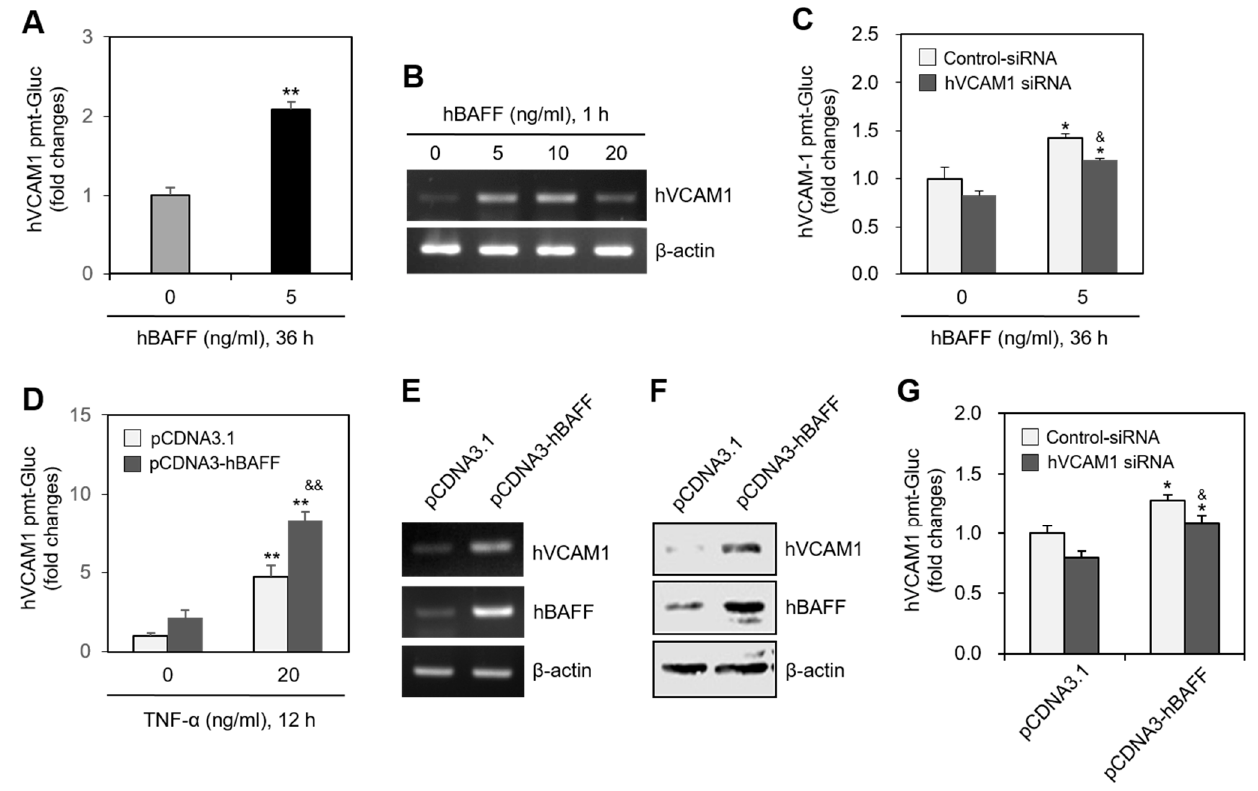
Figure 3. Human vascular cell adhesion molecule-1 (hVCAM1) expression was up-regulated by the treatment or the overexpression of hBAFF. ( A ) MH7A cells were transfected with pEZx-PG02-hVCAM1-gaussia luciferase (Gluc) plasmid DNA by using polyethylenimine (PEI), and treated with 5 ng/mL hBAFF protein. Gluc activity was measured by using luminometer. ( B ) MH7A cells were treated with various concentrations of hBAFF protein. RNA was purified with Nucleozol ® . hVCAM1 expression was detected by RT-PCR. ( C ) MH7A cells were transfected with control or hVCAM1-siRNA to knockdown hVCAM1 expression by using Lipofectamine ® . Then, cells were transfected with pEZx-PG02-hVCAM1-Gluc plasmid DNA by using PEI and treated with 5 ng/mL hBAFF protein. Gluc activity was measured by using luminometer. ( D – F ) MH7A cells were co-transfected with pCDNA3.1, or pCDNA3-hBAFF and pEZx-PG02-hVCAM1-Gluc plasmids by using PEI. Gluc activity was measured by using luminometer ( D ). RNA was purified with Nucleozol ® . hVCAM1 expression was detected by RT-PCR ( E ). Cell lysates were prepared and hVCAM1 protein level was detected by western blot analysis ( F ). ( G ) MH7A cells were transfected with control or hVCAM1-siRNA to knockdown hVCAM1 expression by using Lipofectamine ® . Then, cells were co-transfected with pCDNA3.1, or pCDNA3-hBAFF and pEZx-PG02-hVCAM1-Gluc plasmid DNA by using PEI. Gluc activity was measured by using luminometer. Each experiment was performed at least four times. Data in a bar graph represent the means ± SD. * p < 0.05, ** p < 0.01; significantly different from hBAFF protein-untreated ( A , C ) or pCDNA3.1-treated and TNF- α -untreated ( D , G ) or control group. & p < 0.05, && p < 0.01; significantly different from control-siRNA-treated and hBAFF protein-treated ( C ) or pCDNA3.1-transfected and TNF- α -treated ( D ) or control-siRNA-treated and pCDNA3.1-hBAFF-transfected ( G ) control